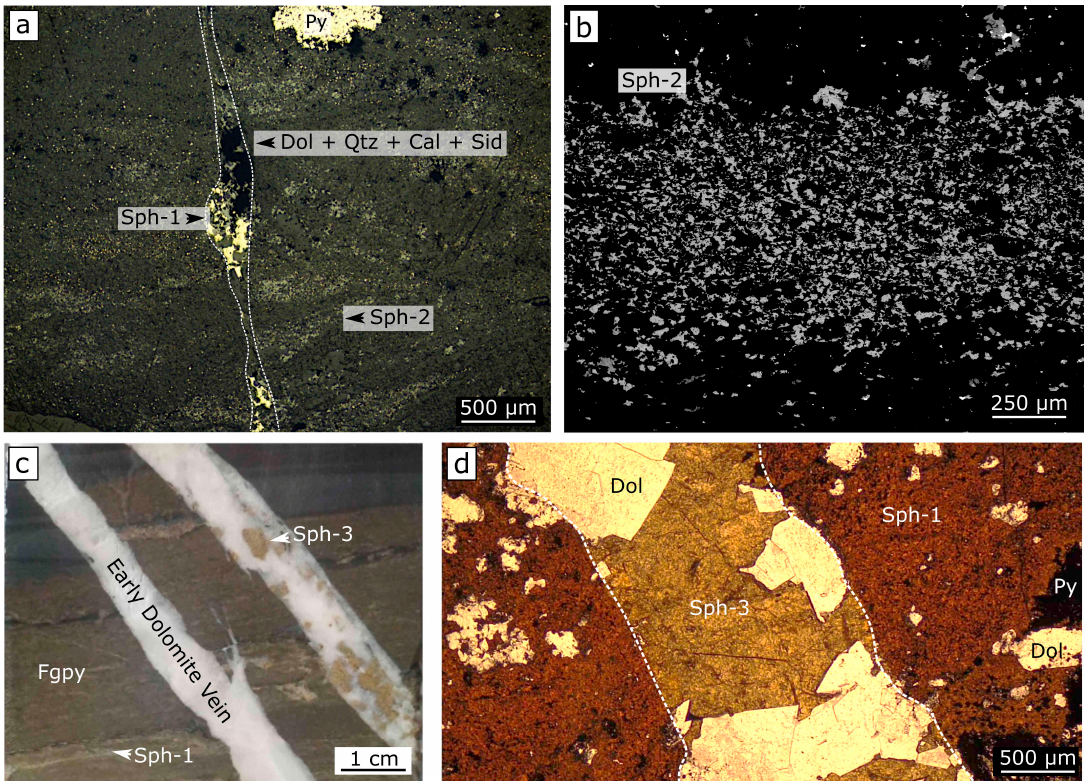
Figure 4. Sphalerite paragenesis at the Hilton Zn-Pb (Ag) deposit (continued). ( a ) Reflected light photomicrograph showing fine-grained disseminated sph-2 splaying out from a discordant sph-1 bearing vein. ( b ) Back-scattered electron image of fine-grained disseminated sph-2. ( c ) An early dolomite vein containing sph-3 cross-cutting a sample containing abundant fine-grained pyrite with minor sph-1. ( d ) Plane polarised light photomicrograph of an early dolomite vein cross-cutting stratabound sph-1 mineralisation. Note the colour difference between sph-1 and sph-3. Abbreviations: sph = sphalerite, dol = dolomite, fgpy = fine-grained pyrite, py = pyrite, qtz = quartz, cal = calcite, sid = siderite.